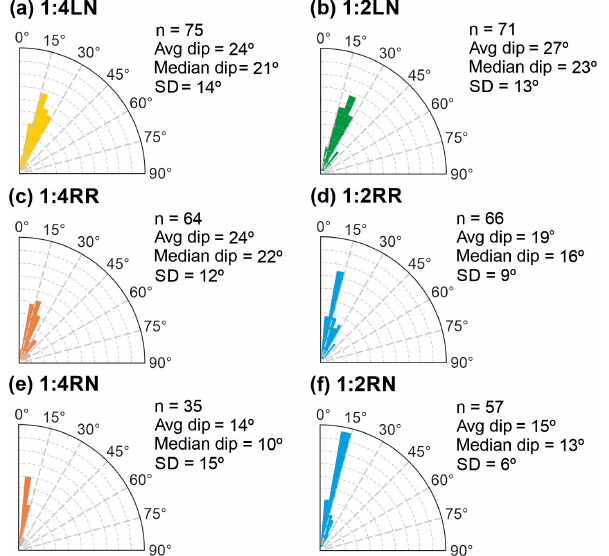
Figure 7. Rose diagrams showing the dips of interpreted faults and their motion. Fault dips interpreted at a vertical exaggeration of (a) 1 : 4, leftward-dipping and normal; (b) 1 : 2, leftward-dipping and normal; (c) 1 : 4, rightward-dipping and reverse; (d) 1 : 2, rightward-dipping and reverse; (e) 1 : 4, rightward-dipping and nor- mal; (f) 1 : 2, rightward-dipping and normal. Note that there are fewer faults presented here than in Fig. 6 due to fewer participants interpreting the fault motion. The n marks the number of faults anal- ysed. SD stands for standard